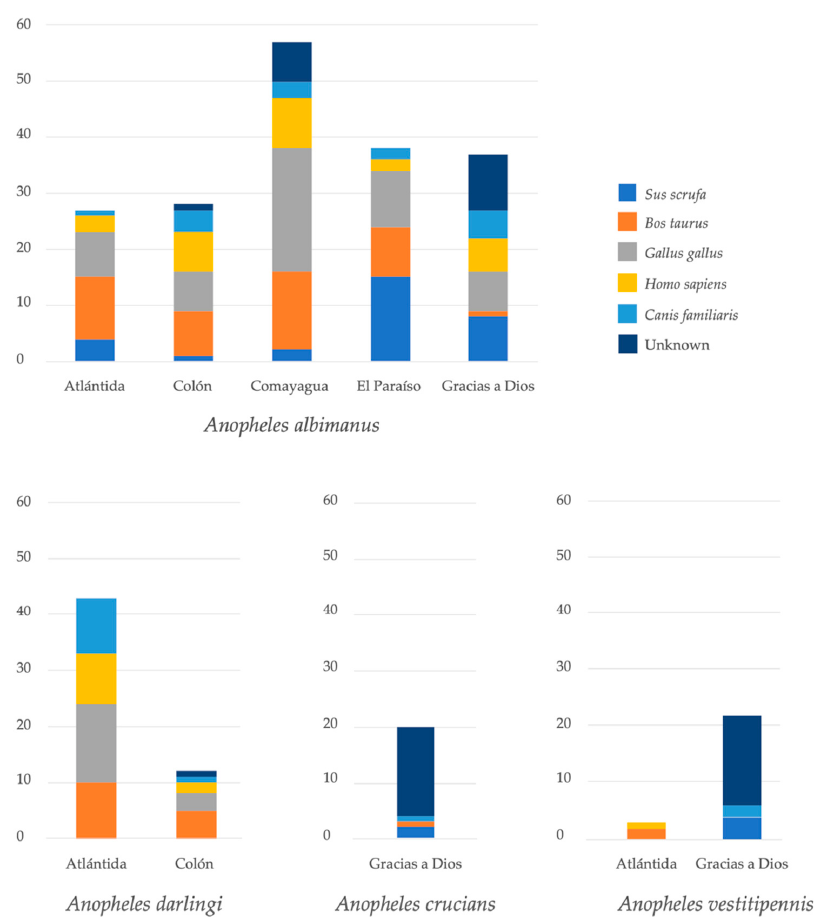
Figure 4. Source of blood meal of four Anopheles spp. according to collection site.